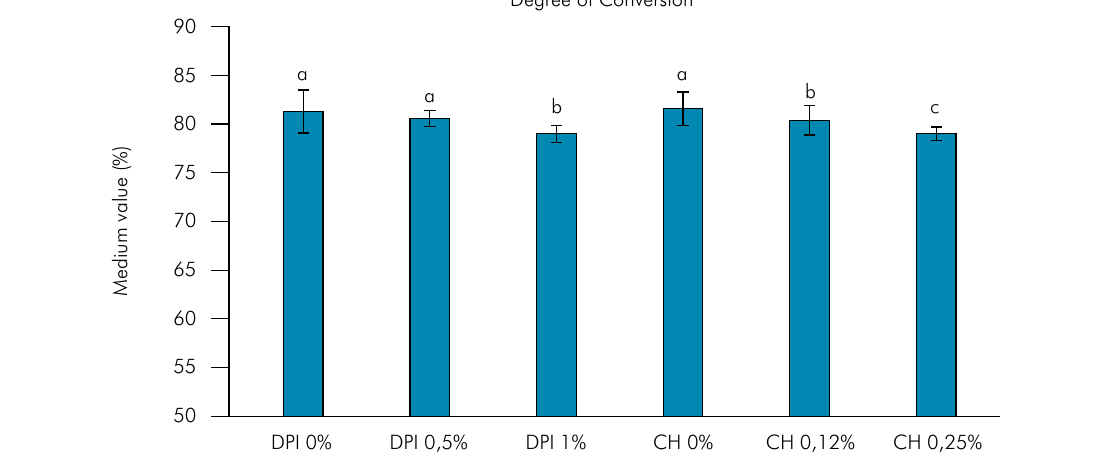
Figure 1. Mean values of degree of conversion (%) of experimental infiltrants, according to DPI (mol%) and chitosan (w%) concentrations.